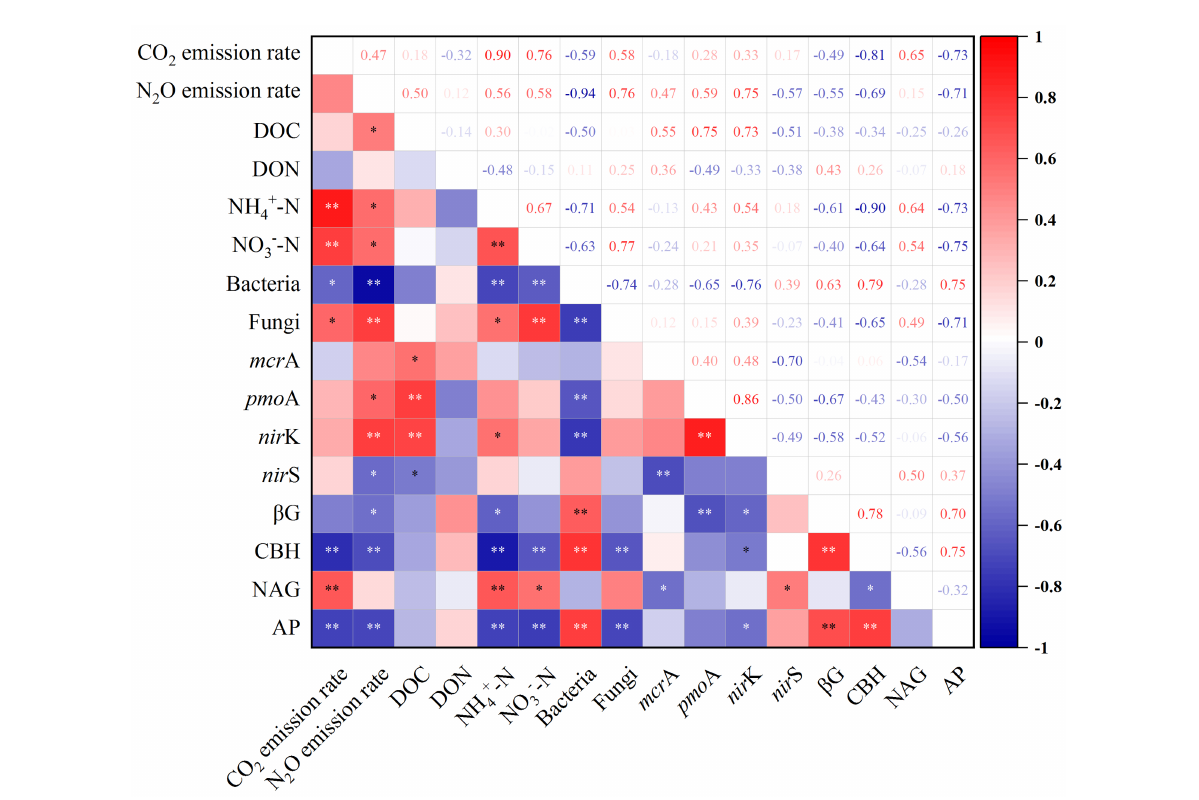
FIGURE 4 Pearson’s correlation analysis of soil CO 2 and N 2 O emissions, carbon and nitrogen contents, microbial abundances, and enzyme activities. β G, β -1,4-glucosidase; CBH, cellobiohydrolase; NAG, β -1,4-N-acetylglucosaminidase; AP, acid phosphatase; DOC, dissolved organic carbon; DON, dissolved organic nitrogen; NH 4+ -N, ammonium nitrogen; NO 3— N, nitrate nitrogen. * indicates significant p < 0.05; ** indicates significant p <